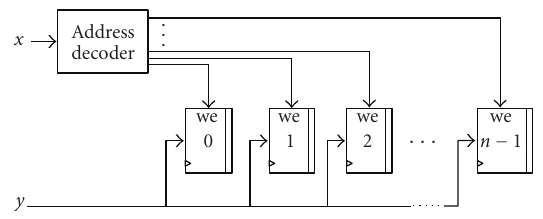
Figure 5: Array write access in